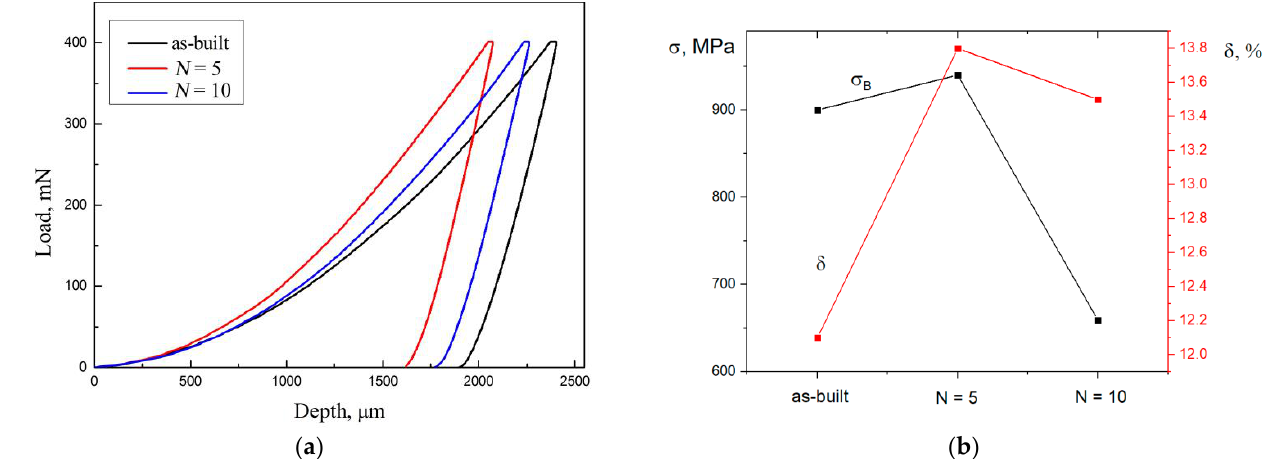
Figure 8. ( a ) Load–depth ( F - d ) indentation curves for samples of the EBM Ti-6Al-4V alloy before and after PIB exposure; ( b ) Dependences of ultimate strength ( σ B ) and deformation to failure ( δ ) of the EBM Ti-6Al-4V alloy on the number of irradiation pulses ( N ). Table 1. Wear rate ( V ), microhardness ( H µ), nanohardness ( H ), and Young’s modulus ( E ) of the EBM Ti-6Al-4V alloy samples before and after PIB modification.